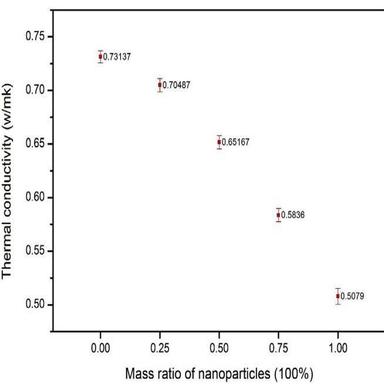
Thermal conductivities of CaCl2·6H2O with different mass ratio of CsxWO3 nanoparticles.